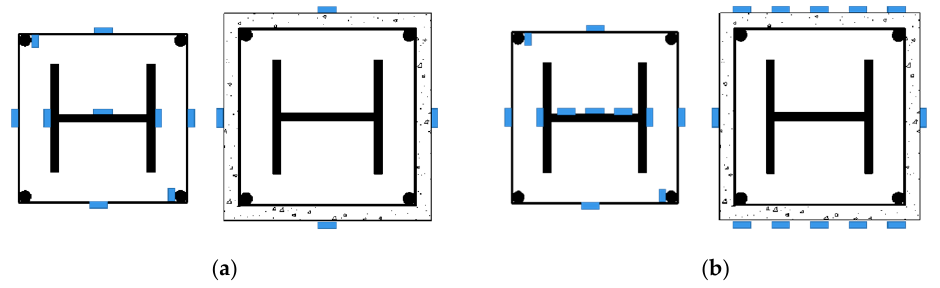
Figure 4. The arrangement of the strain gauges under ( a ) axial and ( b ) eccentric